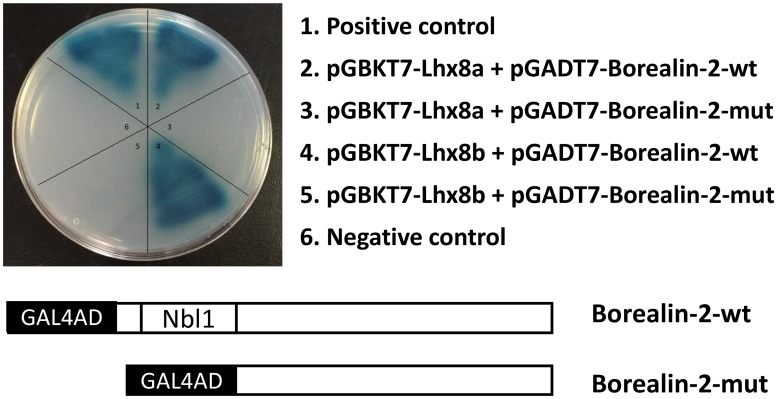
Requirement of the Nbl1 domain of Borealin-2 for interaction with Lhx8 proteins.A DNA fragment encoding Borealin-2 with its Nbl1 domain (amino acid position 28–80) deleted was amplified by PCR using gene-specific primers (Table 1) and cloned into pGADT7 vector, generating a mutant construct, pGADT7-Borealin-2-mut. Interactions between Lhx8 proteins (pGBKT7-Lhx8a or pGBKT7-Lhx8b) and wild type Borealin-2 (pGADT7-Borealin-2-wt) or mutant Borealin-2 (pGADT7-Borealin-2-mut) were assayed by direct yeast two-hybrid analysis. Yeast cells expressing BD and AD fusion proteins were grown on a QDO/X/A plate.